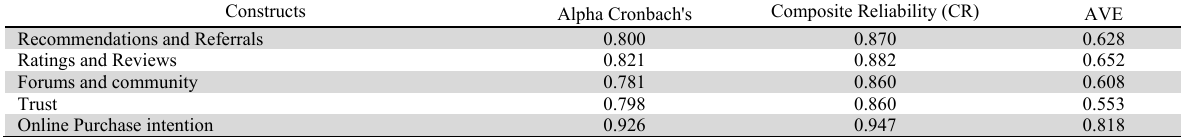
Scale validity and reliability